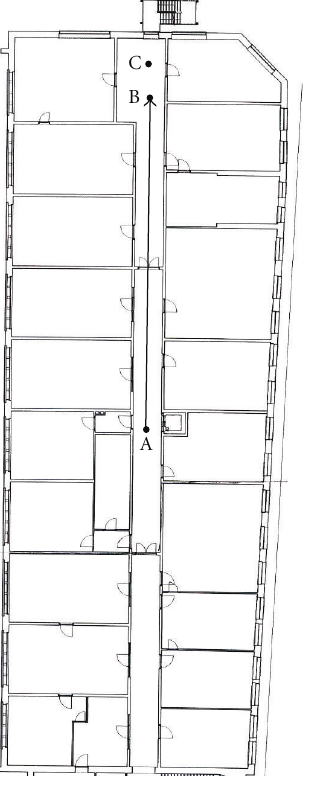
Figure 7: Plan of the indoor environment: the person wearing the firefighter jacket walks for 21 m from the position A to B, while the transmitting access point antenna is positioned in location C.